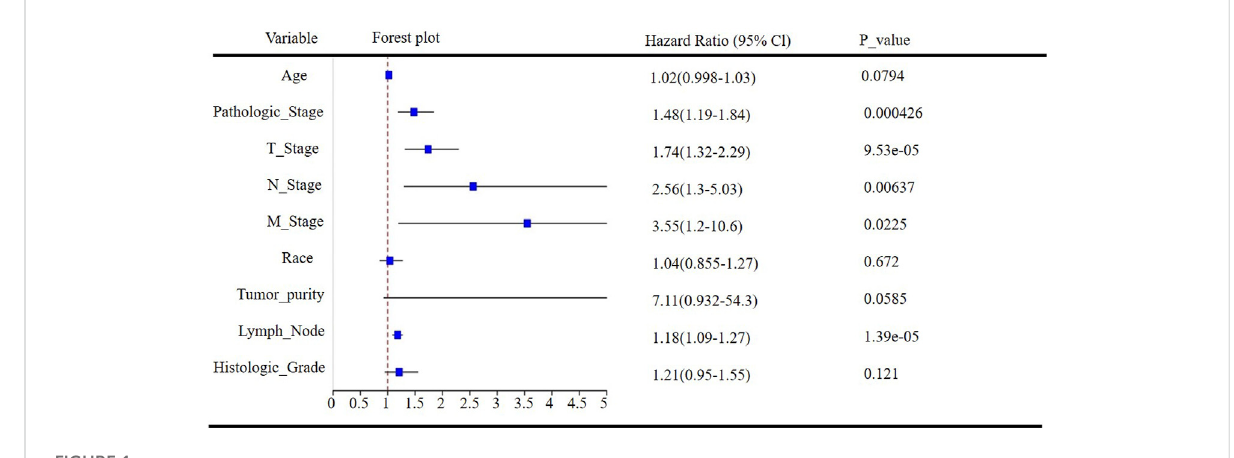
FIGURE 1 Univariate Cox proportional hazard regression analyses for overall